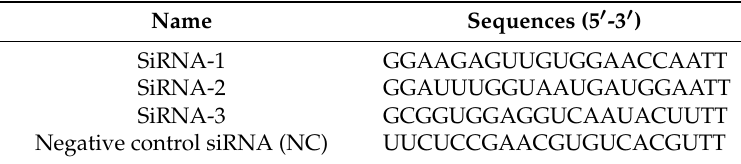
Table 1. Sequences of siRNAs against hnRNP A1 expression.